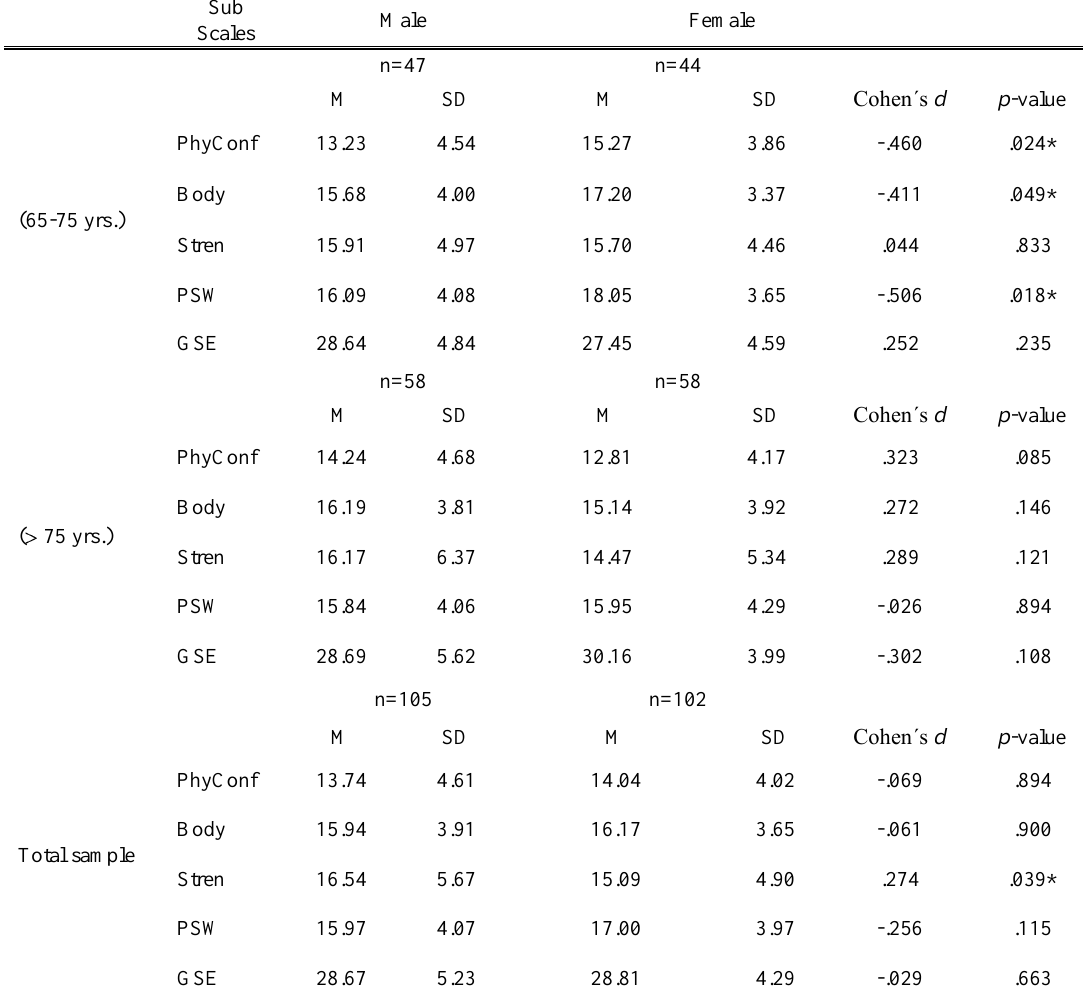
P-values and effect sizes from PSPP sub-scales and global self-esteem by gender and age